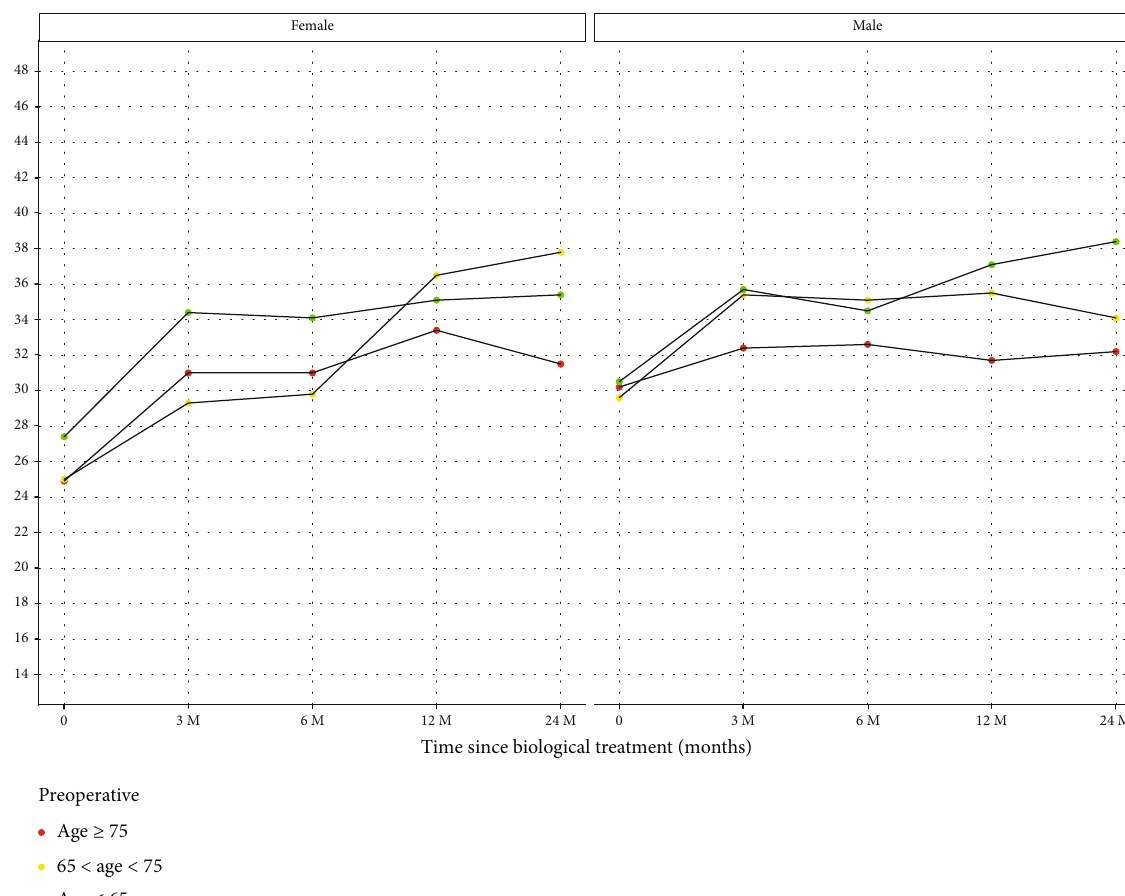
Figure 6: Patients grouped by age at time of treatment (baseline) with follow-up OKS at 3, 6, 12, and 24 months. x -axis: time points in relation to treatment: baseline prior to treatment (0), 3, 6, 12, and 24 months posttreatment. y -axis: OKS mean for each group. Green: age at time of treatment ≤ 65. Yellow: age at time of treatment 65 < age < 75 . Red: age at time of treatment ≥